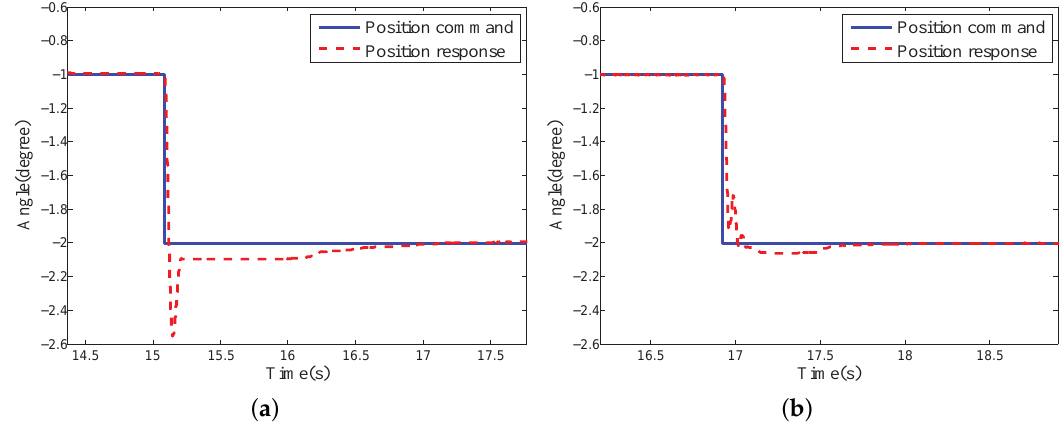
Figure 12. Step response comparison: ( a ) Without finite-time disturbance observer; ( b ) With finite-time disturbance observer.